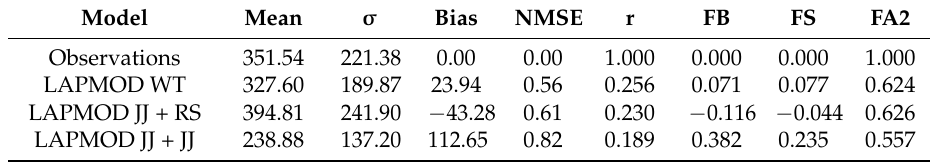
Table 1. Performance statistics for the Indianapolis observations of best quality (Part 1).